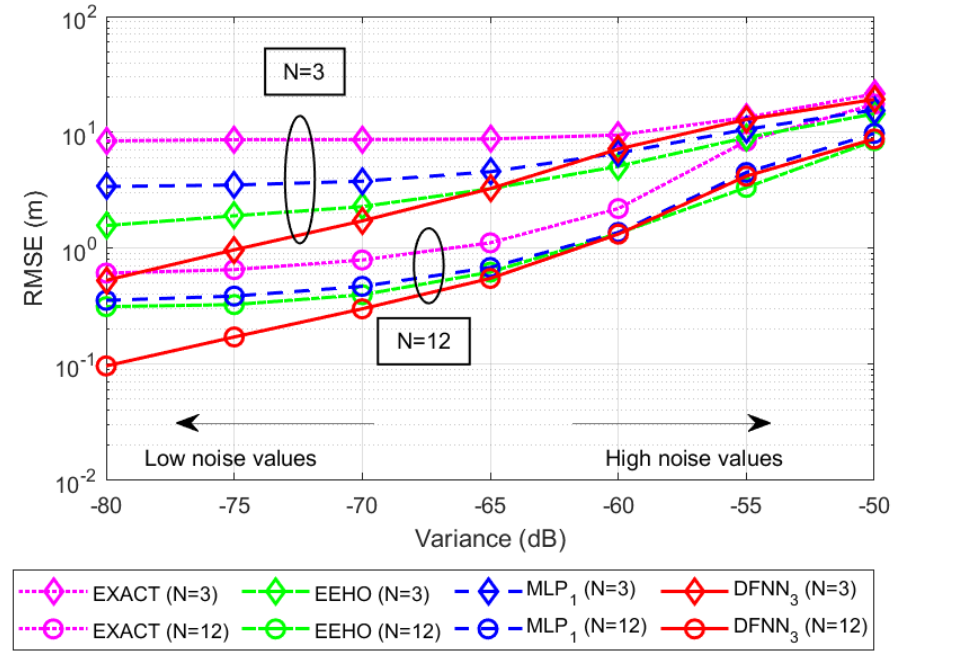
Figure 8. RMSE Comparison of EXACT , EEHO , MLP 1 , and DFNN 3 for N = 3 and N =